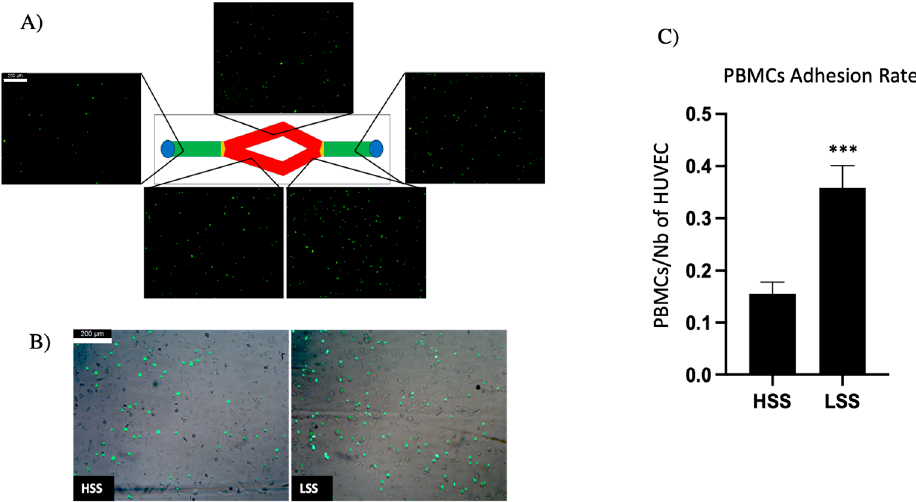
Figure 4. PBMC adhesion assay. ( A ) Leukocyte adhesion on Y-shaped PPFCs; notably, there is a higher adhesion rate in branch segments (indicated in red) compared to straight segments (indicated in green). ( B ) HUVEC monolayer visualized in phase contrast and fluorescent adherent PBMCs. ( C ) Quantification of adhesion rate by fluorescence (*** p < 0.005). Scalebar: 200 μ m.